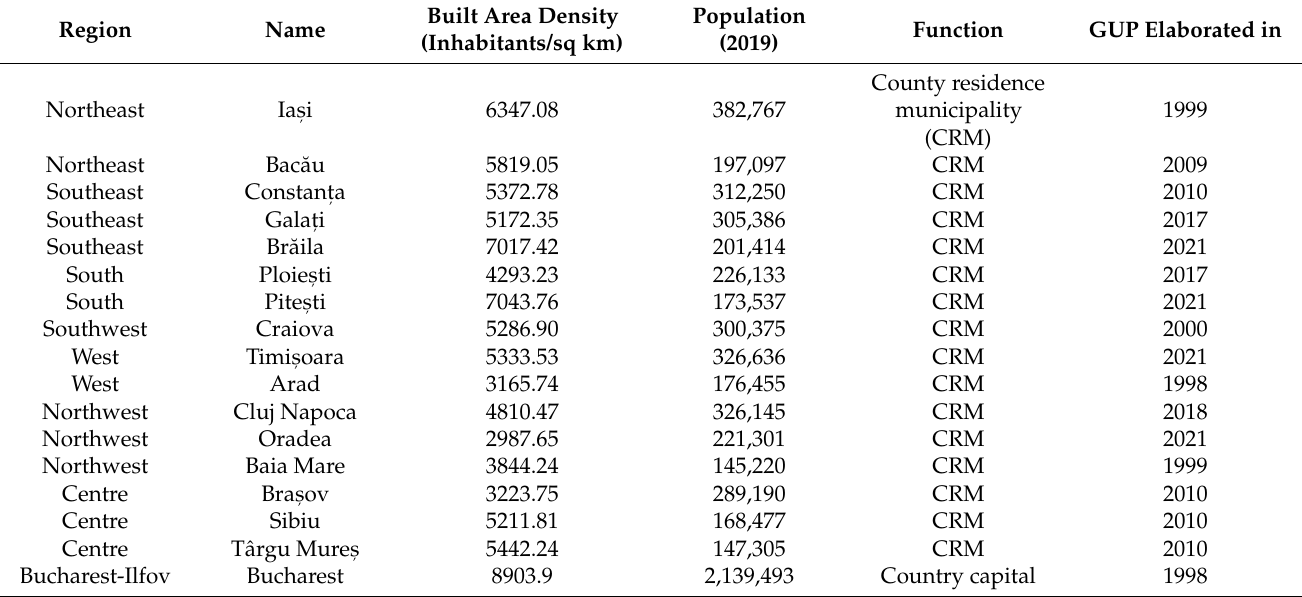
The selection criteria included: the region (minimum one town in each existing de- velopment region), the number of inhabitants (2019 as the year of reference) according to the National Institute of Statistics, the population density (more than 3000 inhabitants/sq km), and the year the GUP had been finalized (before 2000, between 2010–2015, and after 2015).